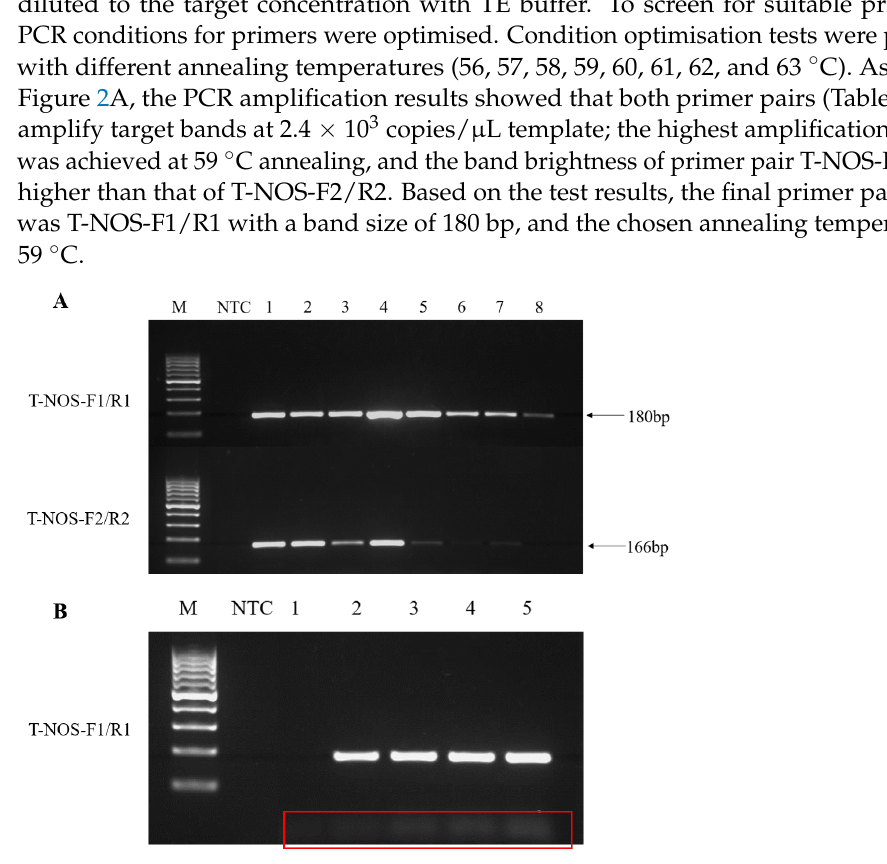
Figure 2. Optimisation of conventional PCR amplification assessed by agarose gel electrophoresis (AGE) conducted using 2.4 × 10 3 copies/μL T-nos plasmid as template. ( A ) AGE visualisation using primer pairs F1/R1 and F2/R2 at different annealing temperatures. Lanes 1 − 8, annealing temperatures (56, 57, 58, 59, 60, 61, 62, and 63 ° C). ( B ) AGE visualisation using primer pairs F1/R1 at different concentrations. Lanes 1 − 5 represent primer concentrations (0.1, 0.2, 0.3, 0.4, and 0.5 μmol/L). Primer dimers are indicated by a red box. M, DNA Ladder H1 (100~1000 bp); NTC, no template control.